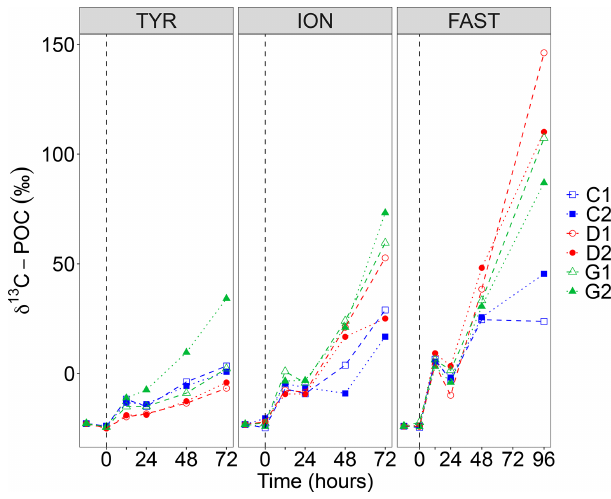
Figure 5. Incorporation of 13 C into particulate organic carbon ( δ 13 C POC) in the six tanks (controls: C1, C2; dust addition under present conditions of temperature and pH: D1, D2; dust addition under future conditions of temperature and pH: G1 and G2) during the three experiments (TYR, ION and FAST). The dashed vertical line indicates the time of seeding (after t